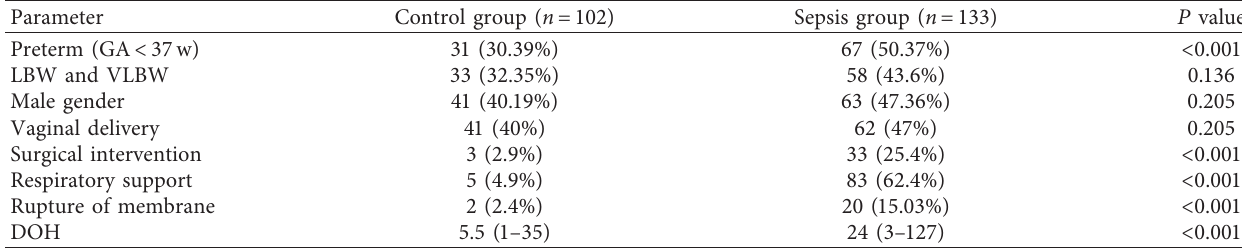
Table 1: Demographic and clinical data of the studied groups.